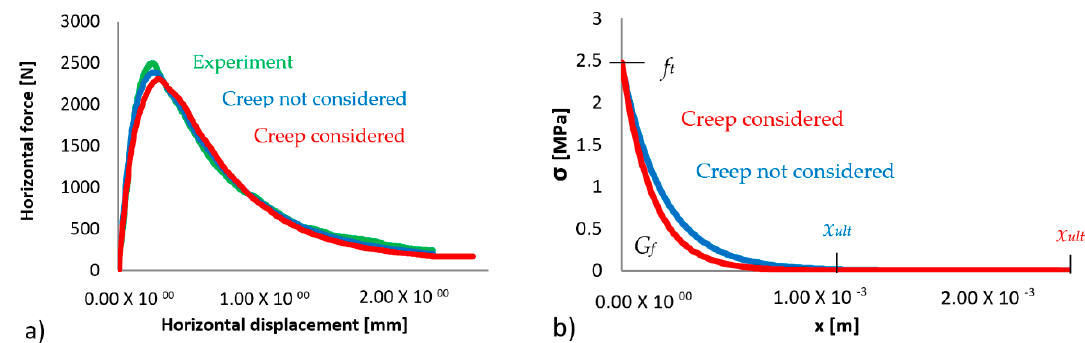
Figure 9. Load-displacement diagram ( a ) and strain-softening behavior ( b ) at 1470 °C.